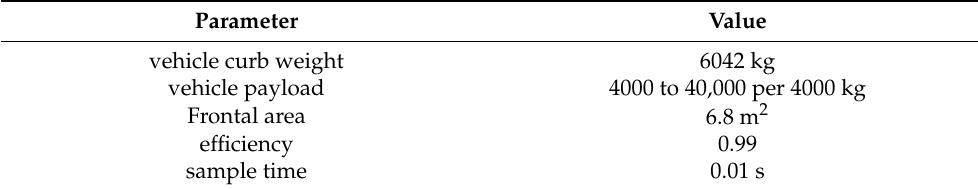
Table 1. Main parameters of simulation